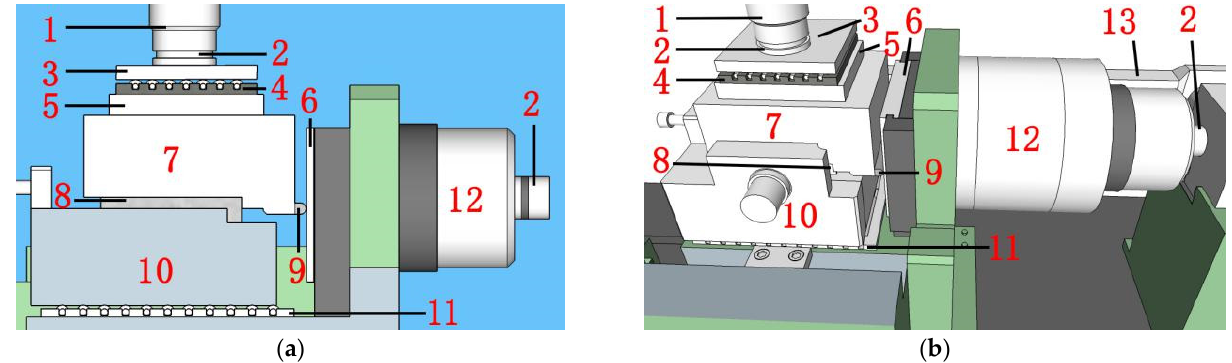
Figure 1. Testing device: ( a ) Front view of the testing device. ( b ) Testing device model. Note: 1-axial actuator, 2-spherical hinge, 3-platen, 4-upper rolling plate, 5-base plate, 6-restrictor plate, 7-upper shearing box, 8-specimen, 9-self-adjusting lever, 10-lower shearing box, 11-lower rolling plate, 12-lateral actuator, 13-connecting rod.